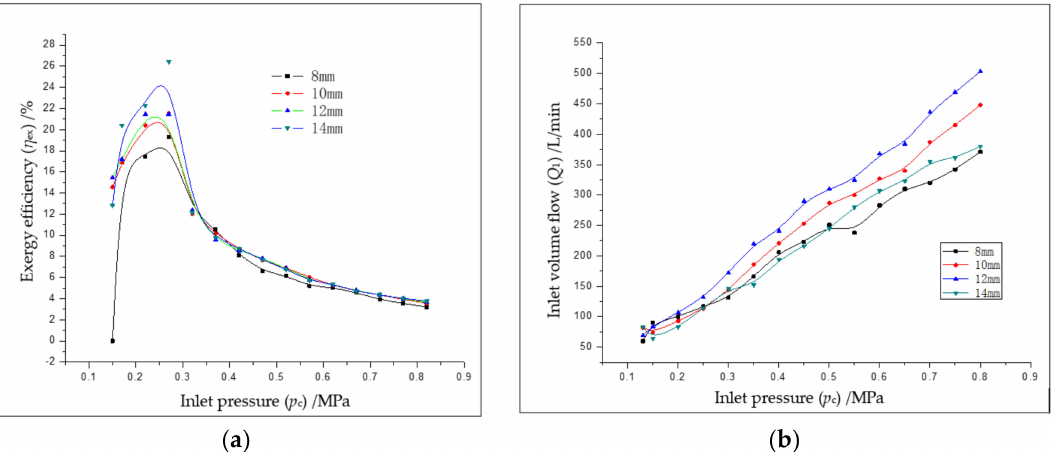
Figure 5. Influence of air inlet size on the performance of the expander: ( a ) influence of inlet size on exergy e ffi ciency; and ( b ) influence of inlet size on inlet